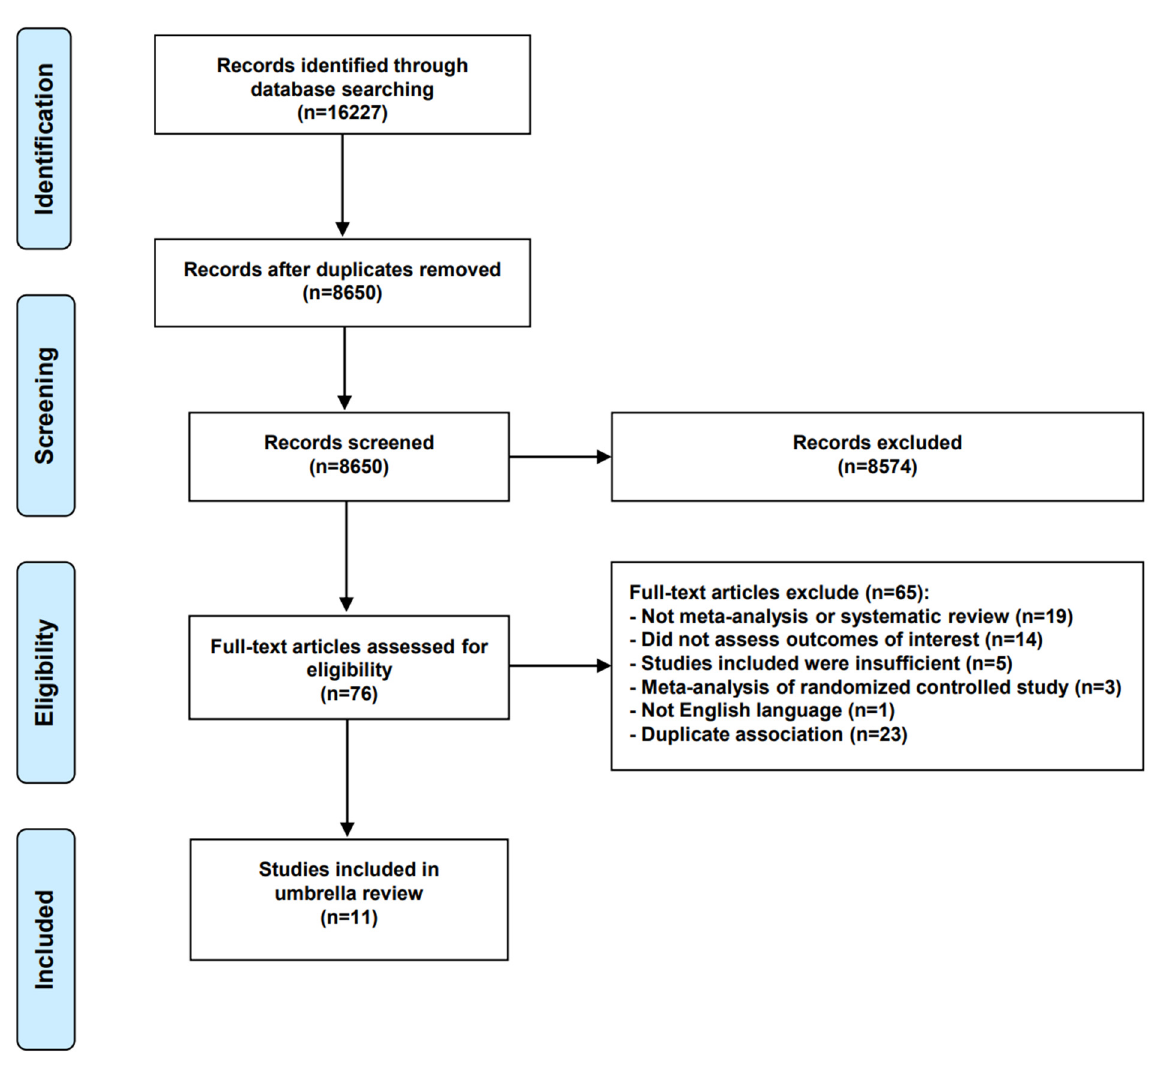
Figure 1. Literature search flow diagram.